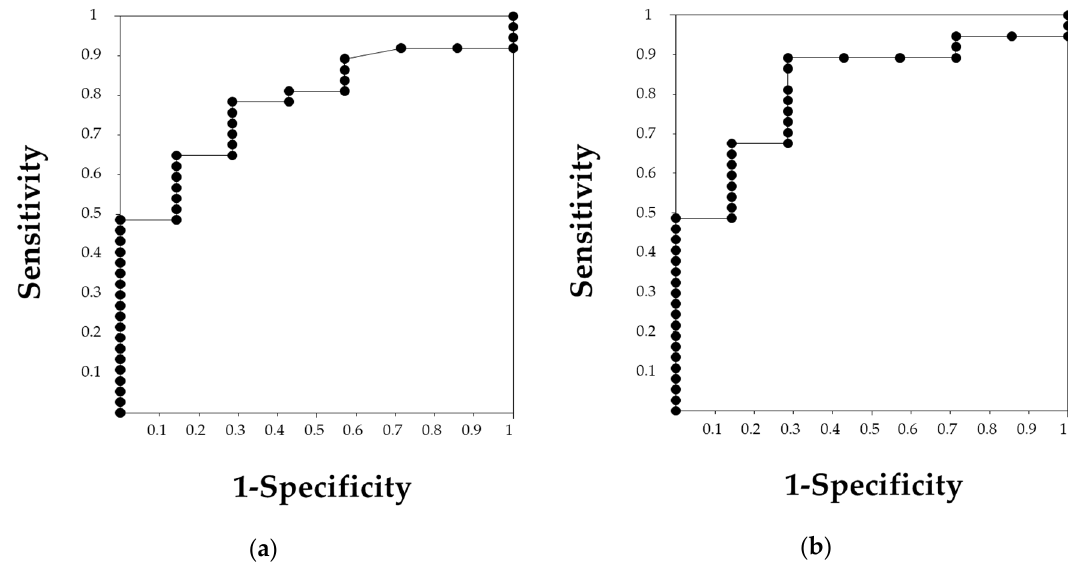
Figure 3. The receiver operating characteristic (ROC) curve of neutrophil-to-lymphocyte ratio (NLR) and platelet-to-lymphocyte ratio (PLR) for predicting renal outcome. ( a ) The ROC curve of NLR showing an area under the curve (AUC) of 0.782. An NLR of 4.0 was the cutoff value with a sensitivity of 78.4% and a specificity of 71.4%. ( b ) The ROC curve of PLR showing an AUC of 0.819. The cutoff value of 137.7 was determined with a sensitivity of 89.2% and a specificity of 71.4%.